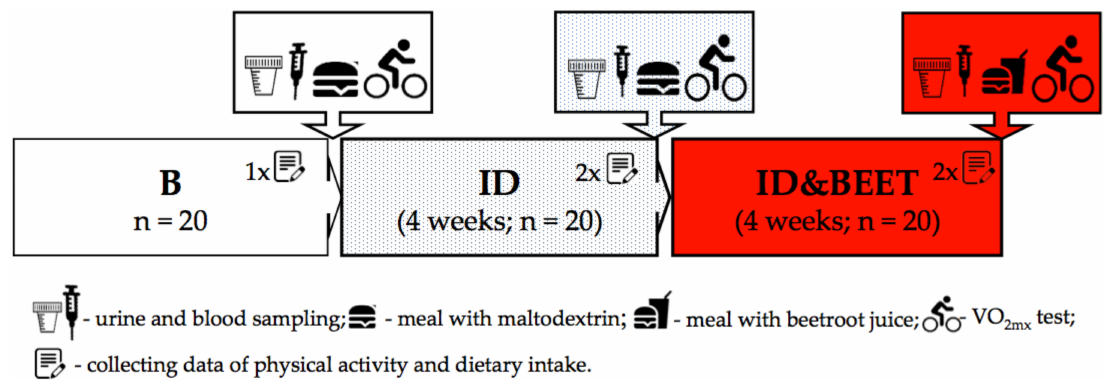
Figure 1. Study design. On the last day of each stage blood samples were collected and after a special meal, a maximum rate of oxygen uptake (VO 2max ) was conducted. B: The first stage of the study (baseline characteristic); ID: The second stage of the study (implementation of dietary recommendations without beetroot juice supplementation); ID&BEET: The third stage of the study (implementation of dietary recommendations with beetroot juice